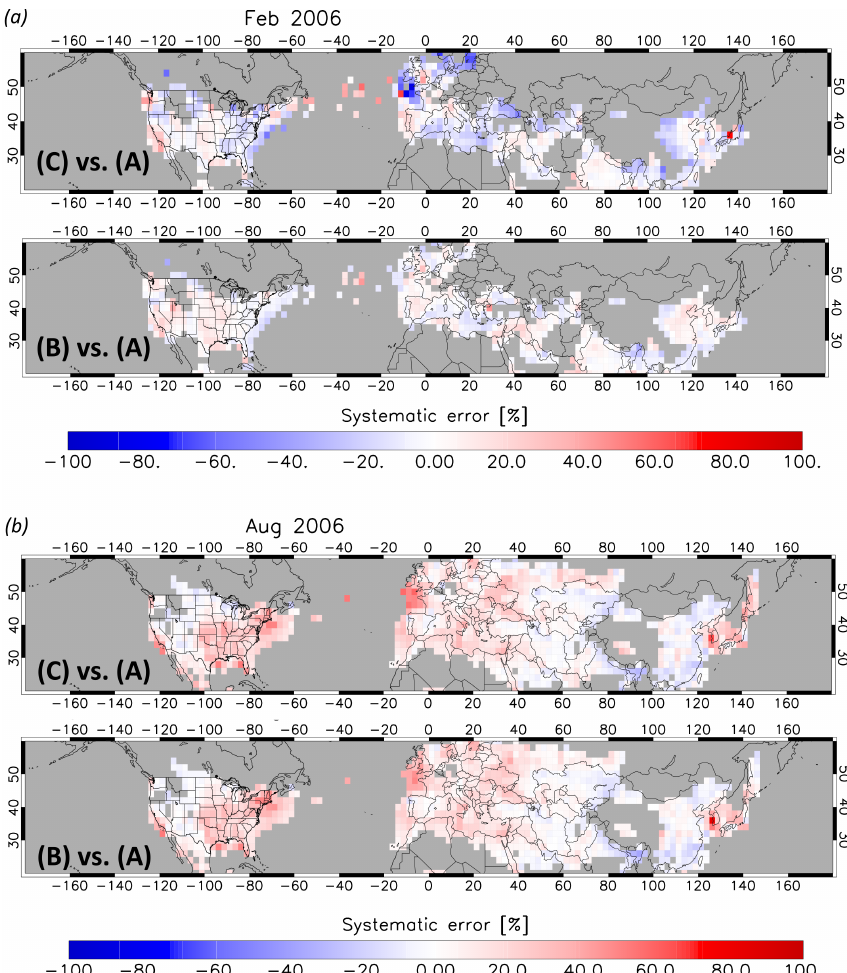
Figure 10. Relative difference between local monthly mean OMI:GEOS-Chem NO 2 column ratios for (a) February 2006 between method (C) and (A) (upper panel) and between method (B) and (A) (lower panel), and (b) August 2006. Relative difference defined as 100% × ((C / A) − 1), and 100% × ((B / A) −